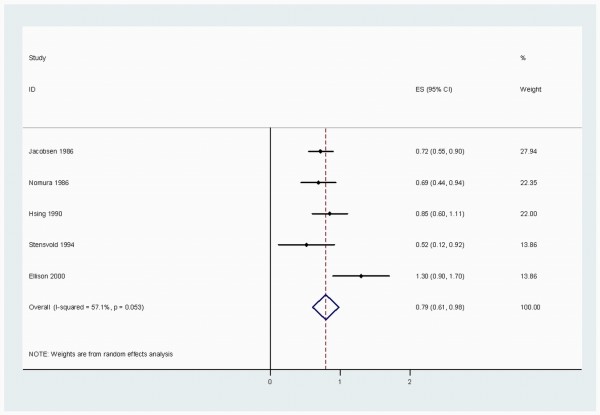
Summary RRs of prostate cancer for high coffee drinkers versus non/lowest drinkers from included studies. Squares represent study-specific relative risk estimates (size of the square reflects the study-specific statistical weight, that is, the inverse of the variance); horizontal lines represent 95% CIs; diamonds represent summary relative risk estimates with corresponding 95% CIs.